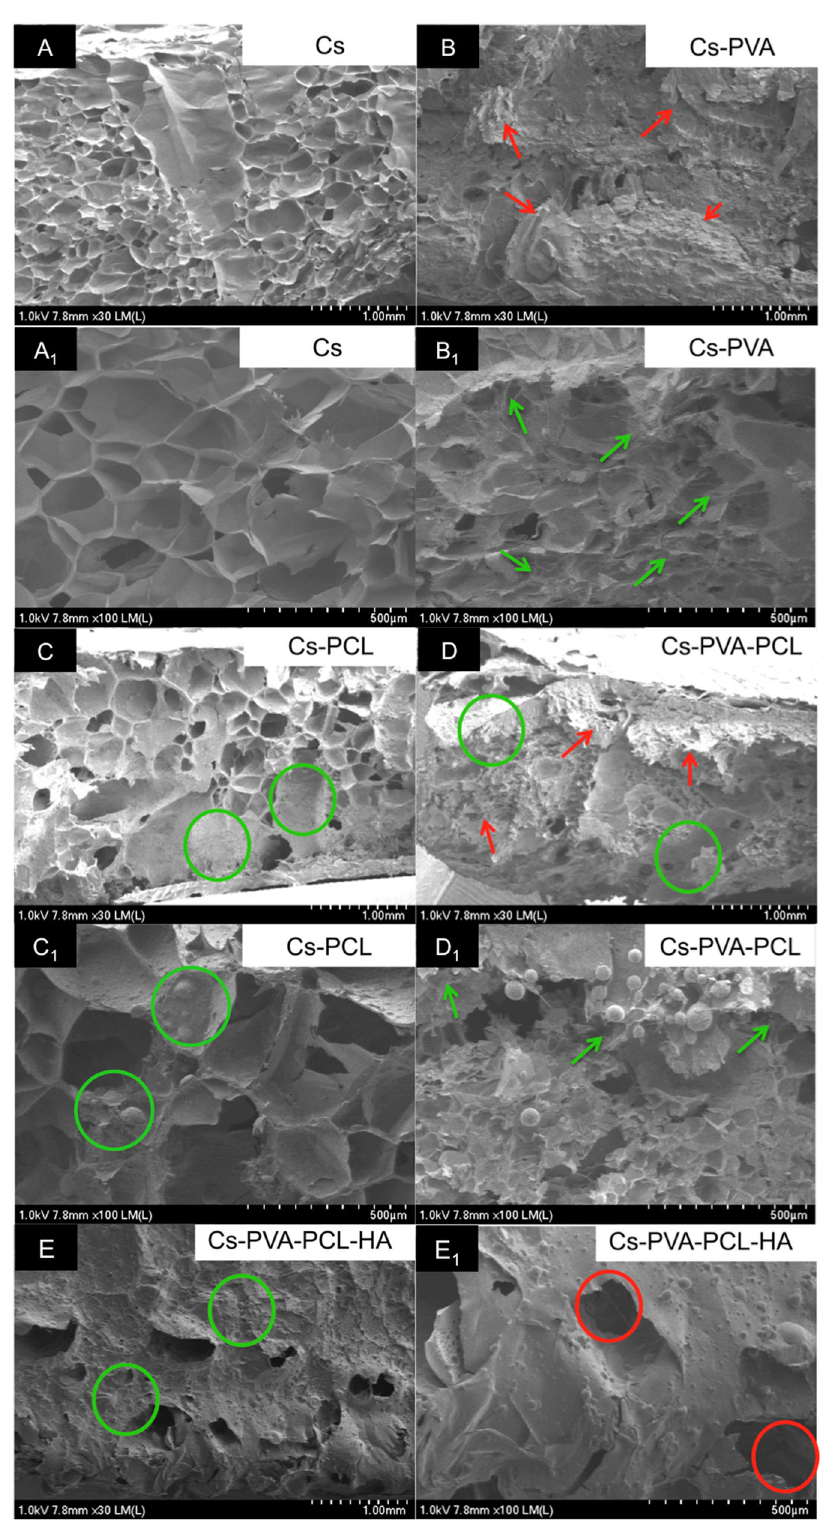
CO (BINDER 13-16721 incubator, Germany) with 2 humidity for 48 h. After the elapsed time, the culture medium was removed and new medium was added. This